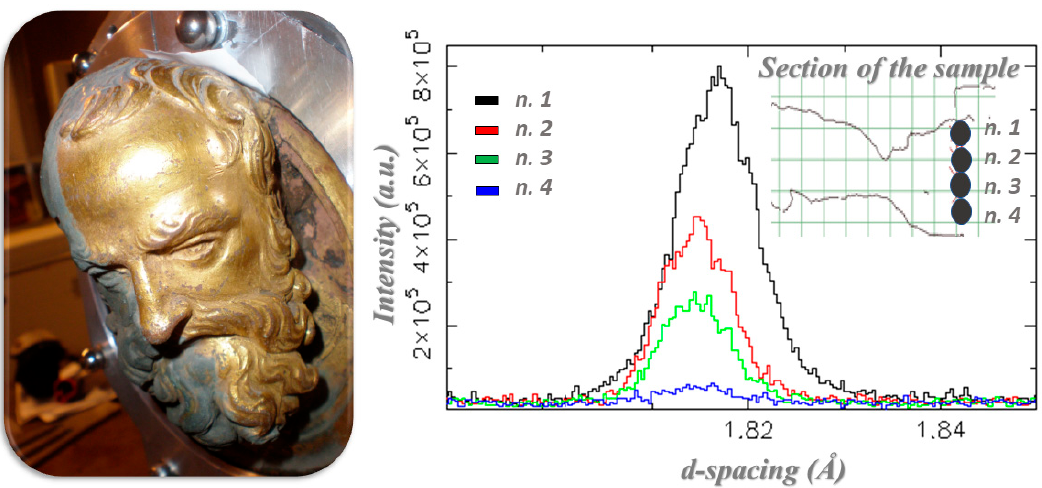
Figure 5. ( Left ) The “prophet head”, by Lorenzo Ghiberti, part of the gilded-bronze door of the Florence baptistery; ( Right ) di ff raction patterns of strain scan along the base-plate vertical section of the relief